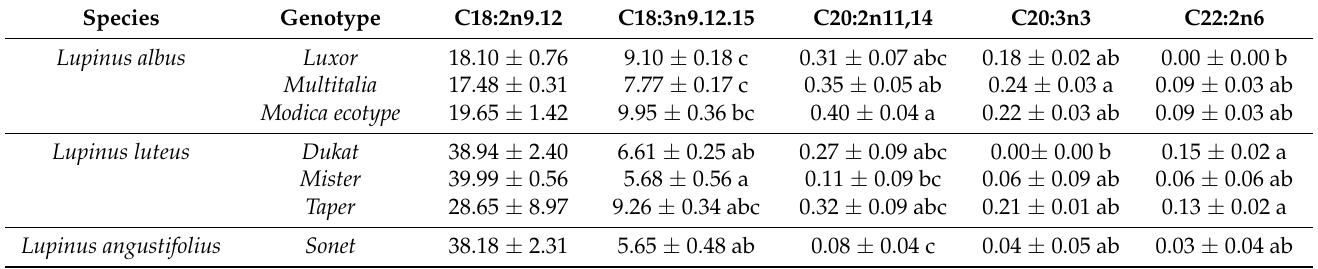
Table 6. Polyunsaturated fatty acid profiles of seed oil extracted from different Lupinus spp.